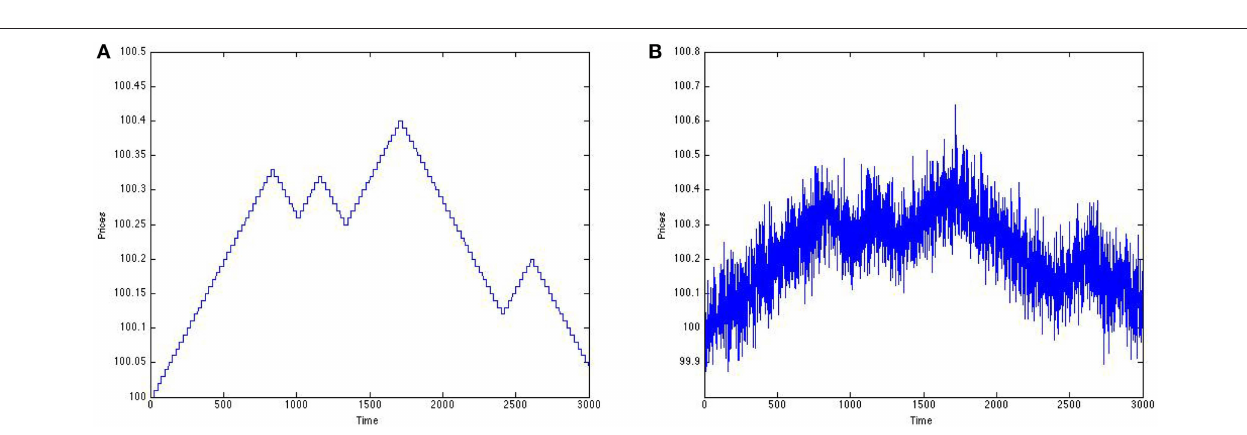
FIGURE 14 | Prices before and after noise from small scale traders. (A) Before noise. (B) After